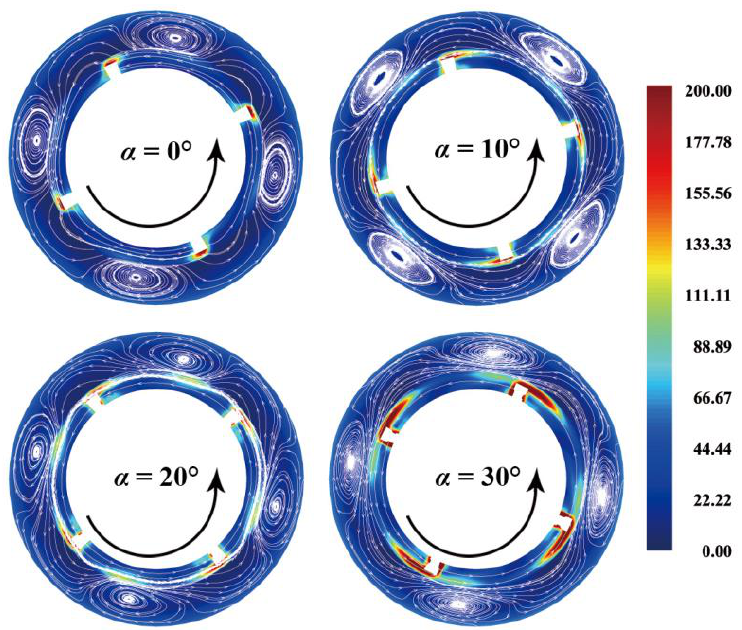
Figure 12. Vorticity and streamline distribution of the hole cleaning device under different helix angles.